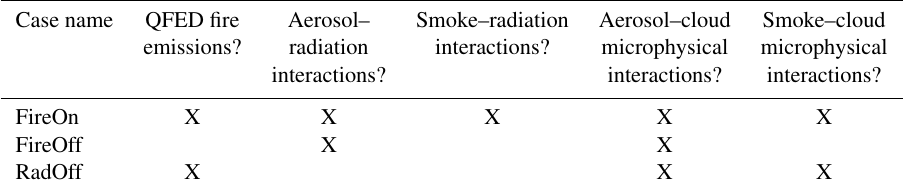
Table 1. Differences between the WRF-CAM5 FireOn, FireOff, and RadOff cases. X marks indicate that a phenomenon is included in the simulation, whereas the lack of a mark indicates that the phenomenon is excluded. “Aerosol” refers to all aerosol species, whereas “Smoke” refers specifically to the aerosol attributable to the QFED fire